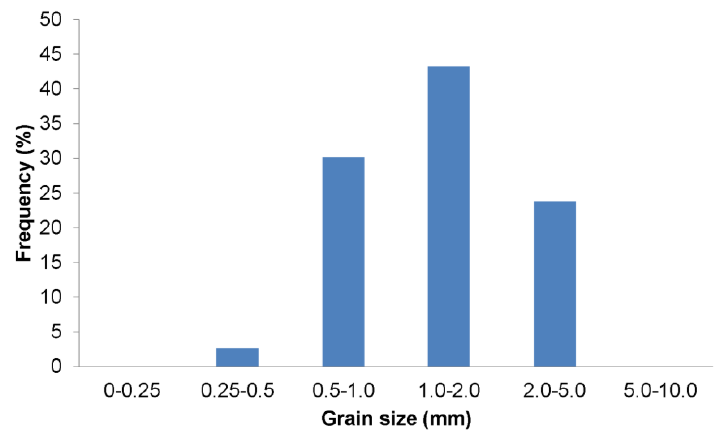
Figure 3. Histogram of grain size distribution by weight percent of fraction.